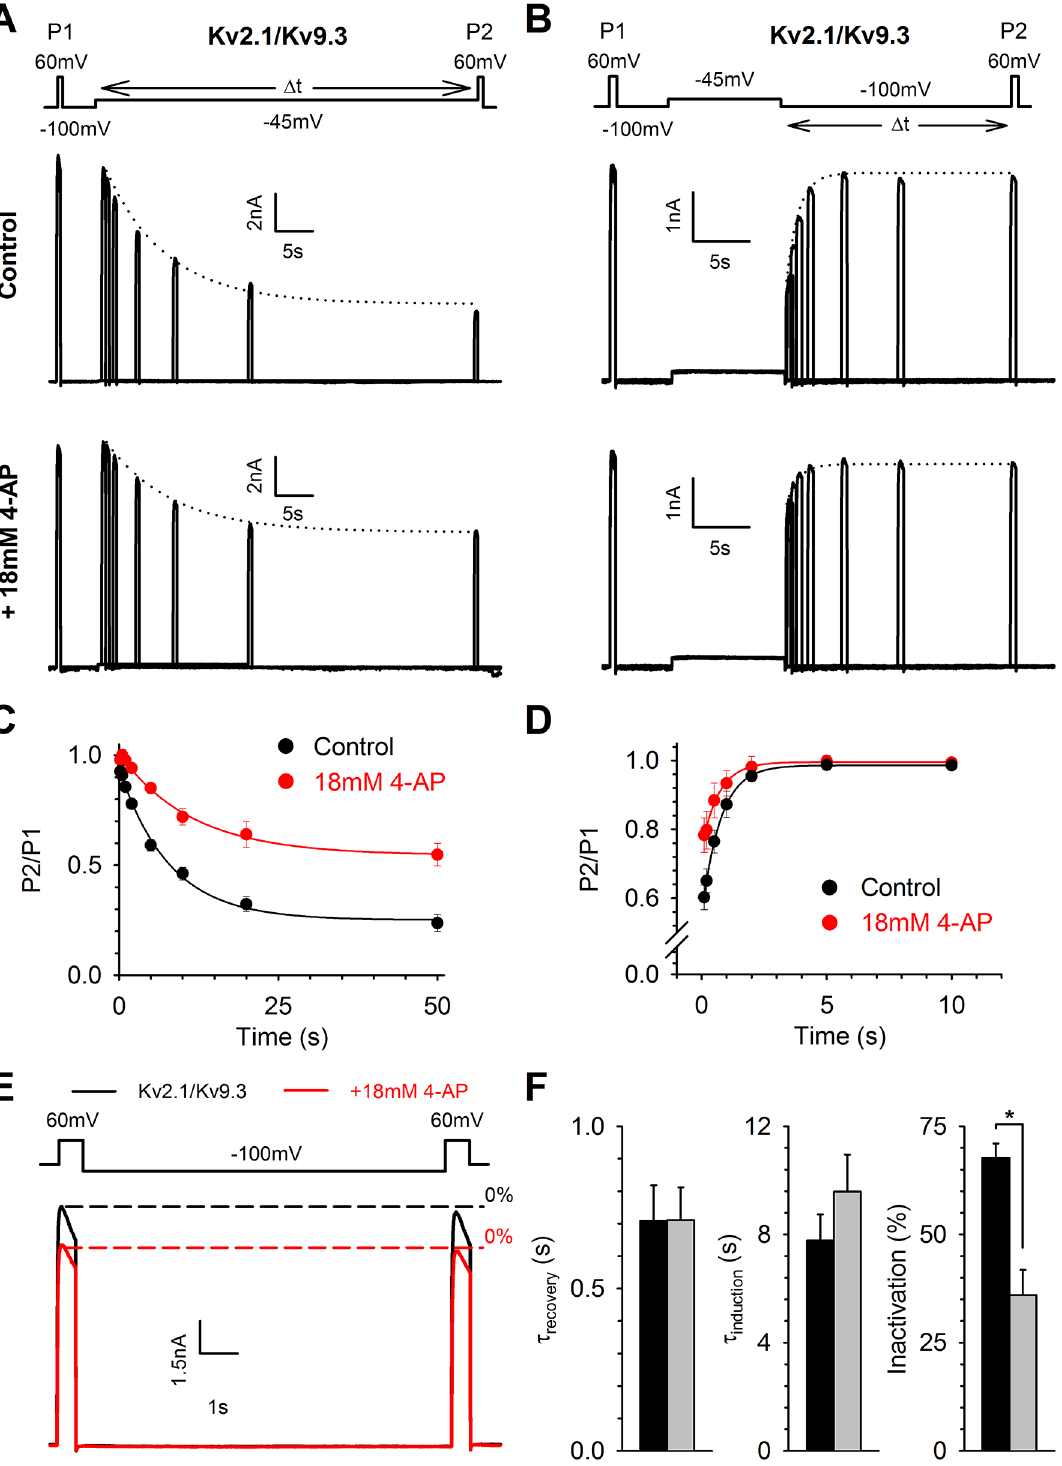
Fig 5. 4 − AP does not affect closed − state inactivation in Kv2.1/Kv9.3 heterotetramers. (A − B) Representative current recordings under control (upper) and 4 − AP (bottom) conditions elicited by the pulse protocols shown on top. The pulse protocols were used to investigate the induction (A) and recovery (B) of closed − state inactivation. The dotted lines represent the exponential fit to determine these rate constants. (C − D) The normalized plot of induction at − 45 mV (C) and recovery at − 100 mV (D) of closed − state inactivation was obtained as described in Fig 4. Solid lines represent the exponential fit. 4 − AP